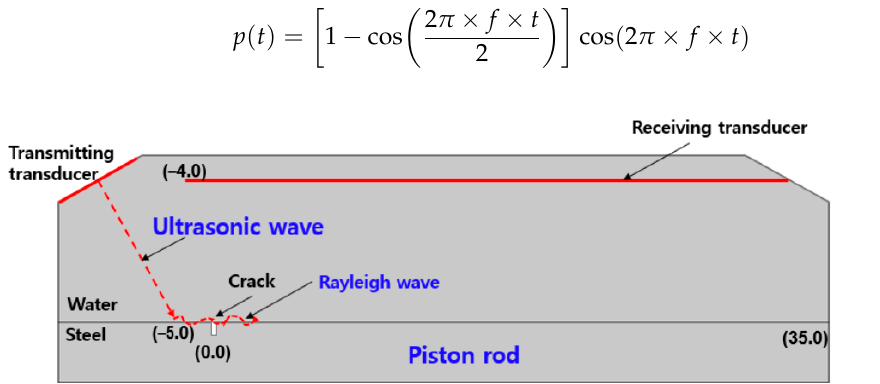
Figure 2. Diagram showing simulation setup.